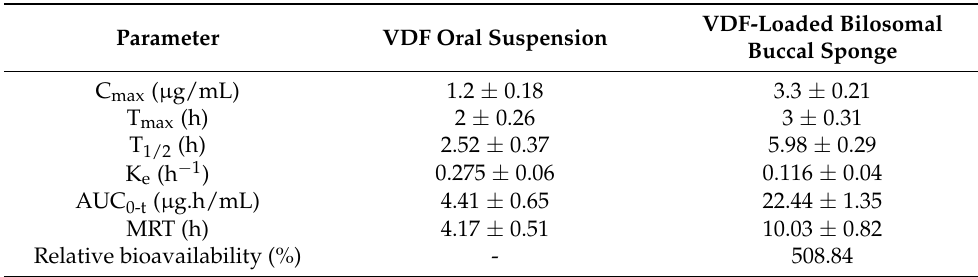
Table 4. Pharmacokinetic parameters of plain VDF (20 mg/kg, p.o.) and VDF-loaded bilosomal buccal formulation (20 mg VDF/kg).